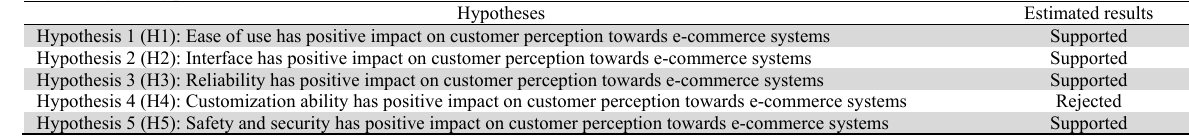
Summary of hypothesis estimation